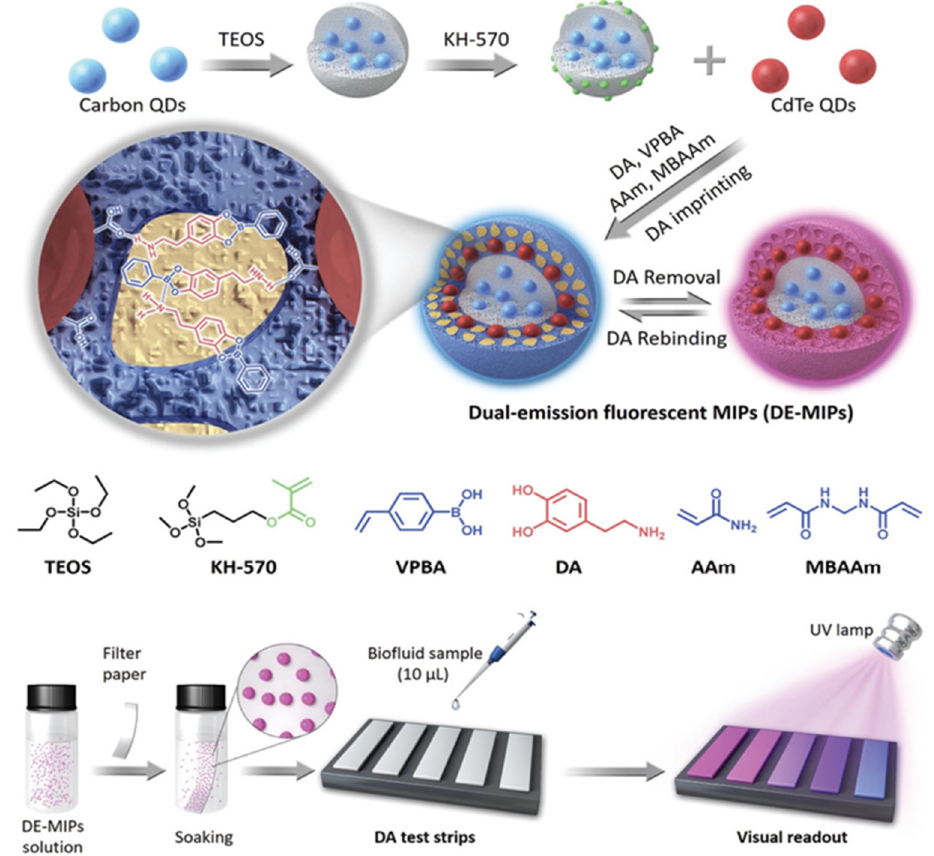
Figure 10. General scheme of generation and operation of the QDs@MIP. Reproduced with permis- sion from [83].